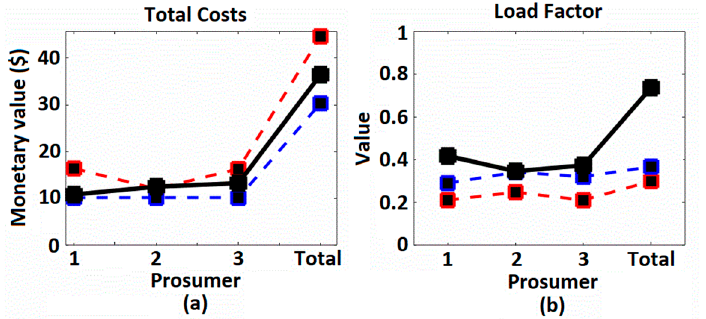
Figure 4. Values related to total costs for energy consumption and LF in the prosumers’ community. ( a ) Values of total monetary costs; and ( b ) LF values.